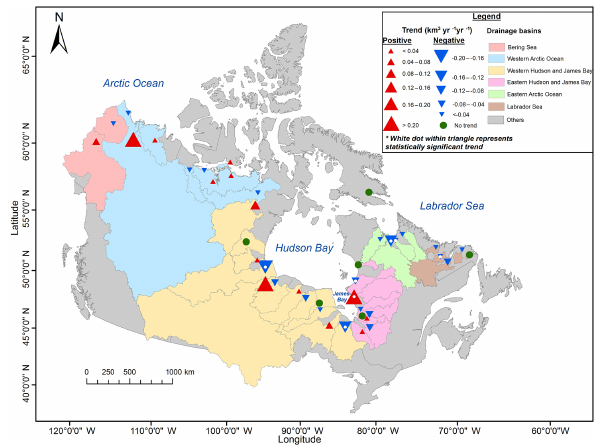
Figure 6. Spatial trend analysis for the annual discharge of 42 rivers of northern Canada,